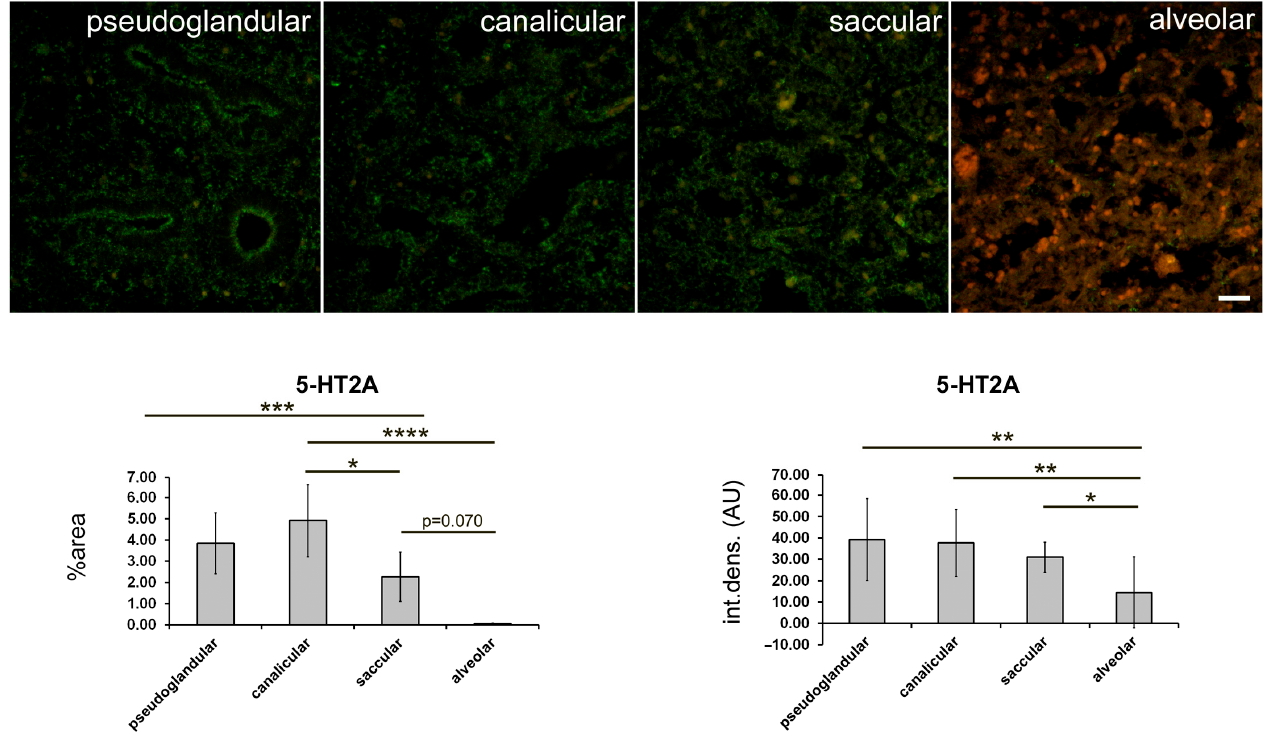
Figure 5. Quantification of 5-HT2A expression at different stages of fetal lung development. Immunofluorescence with 5-HT1A antibodies was performed. Representative images for different stages of lung development are shown. Green fluorescent staining—positive 5-HT2A receptor expression. Images were acquired at 400× magnification. Scale bar = 50 µm. Percentage of a sectional area with positive signal (% area) and integrated density (int. dens.; arbitrary fluorescence units—AU) were measured and are shown in graphs. * p < 0.05; ** p < 0.01; *** p < 0.001; **** p < 0.0001 between indicated developmental stages (bars).